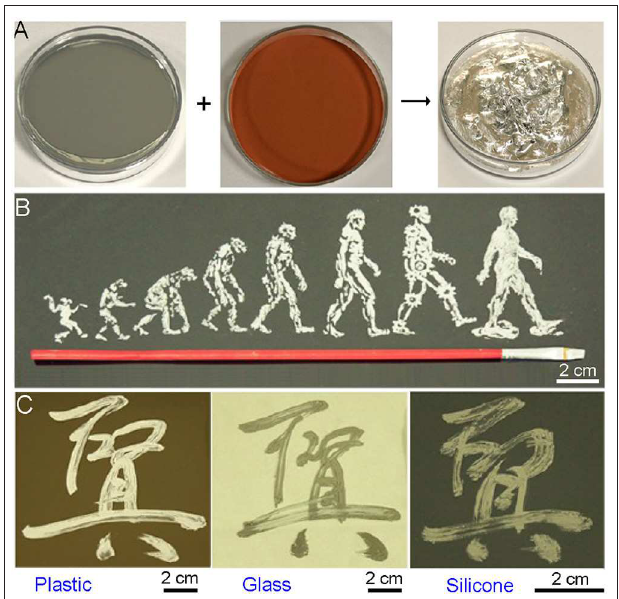
FIGURE 5 | Images of GaIn 24.5 , Cu particles, and TransM 2 ixes ( φ = 0.1) (A) , and a piece of artistic work painted with a painting brush on plastic substrate using TransM 2 ixes ( φ = 0.1) (B) , and three TransM 2 ixes ( φ = 0.1)-made Chinese calligraphy works written with a traditional Chinese brush on plastic, glass, and silicone substrates, respectively (C) . Reproduced with permissions from Tang et al. (2017). Copyright 2017, American Chemical Society.